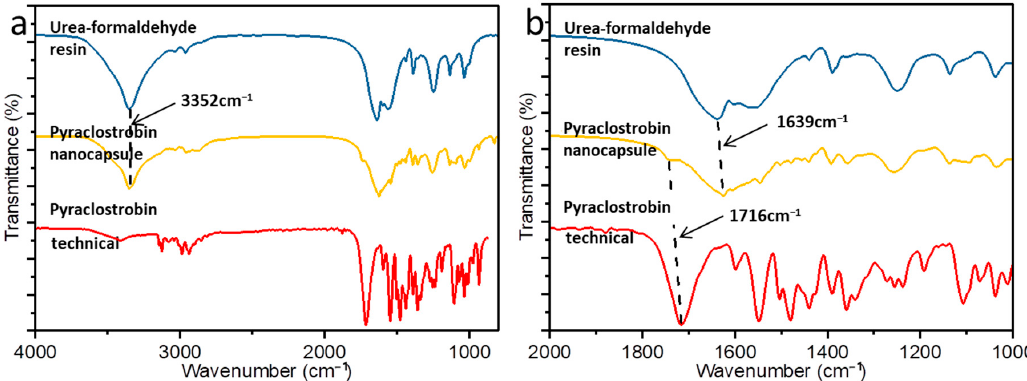
Figure 6. ( a ) Fourier-transform infrared spectra of urea–formaldehyde resin, pyraclostrobin nanocapsules, and technical pyraclostrobin. ( b ) Magnified regions of the spectra.